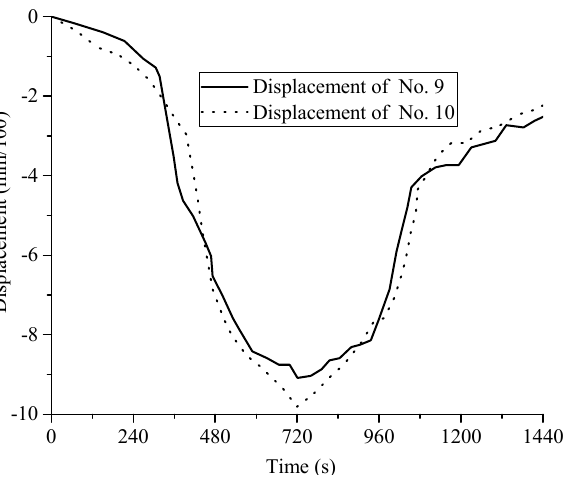
Figure 12. The relationship between displacement and time for No. 9 and No. 10 displacement meters, under the condition of first-down and then-up crossing.